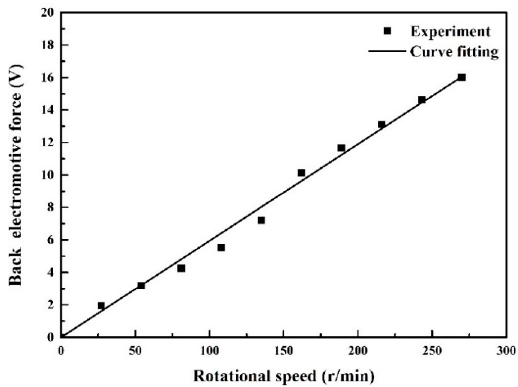
Figure 4. The relationship between the back electromotive force and the rotational speed of the generator.